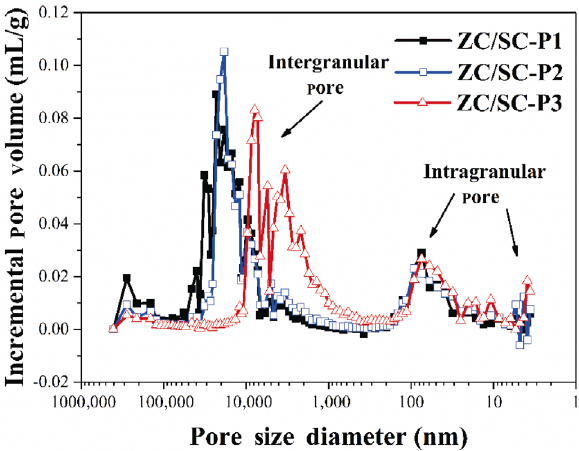
Fig. 11 Pore size distribution of the porous ZrC/SiC ceramics via solvent evaporation methods [21]. Reproduced with permission from Ref. [21], © Elsevier Ltd and Techna Group S.r.l.